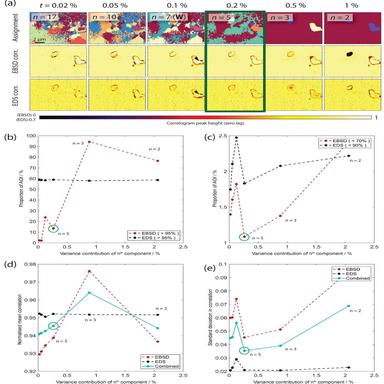
(a) Effect of varying variance rejection percentage on measured EBSD pattern and spectrum cross-correlation peak height with corresponding RC-EBSPs and RC-spectra. Colour is cross-correlation peak height. (b) and (c) show percentage of these EBSD and EDS cross-correlation peak heights greater or less than cut-off proportions of maximal correlation in that analysis. (d) and (e) show mean and standard deviation of the cross-correlation peak heights for EBSD, EDS and the quadrature combination of the two. (For